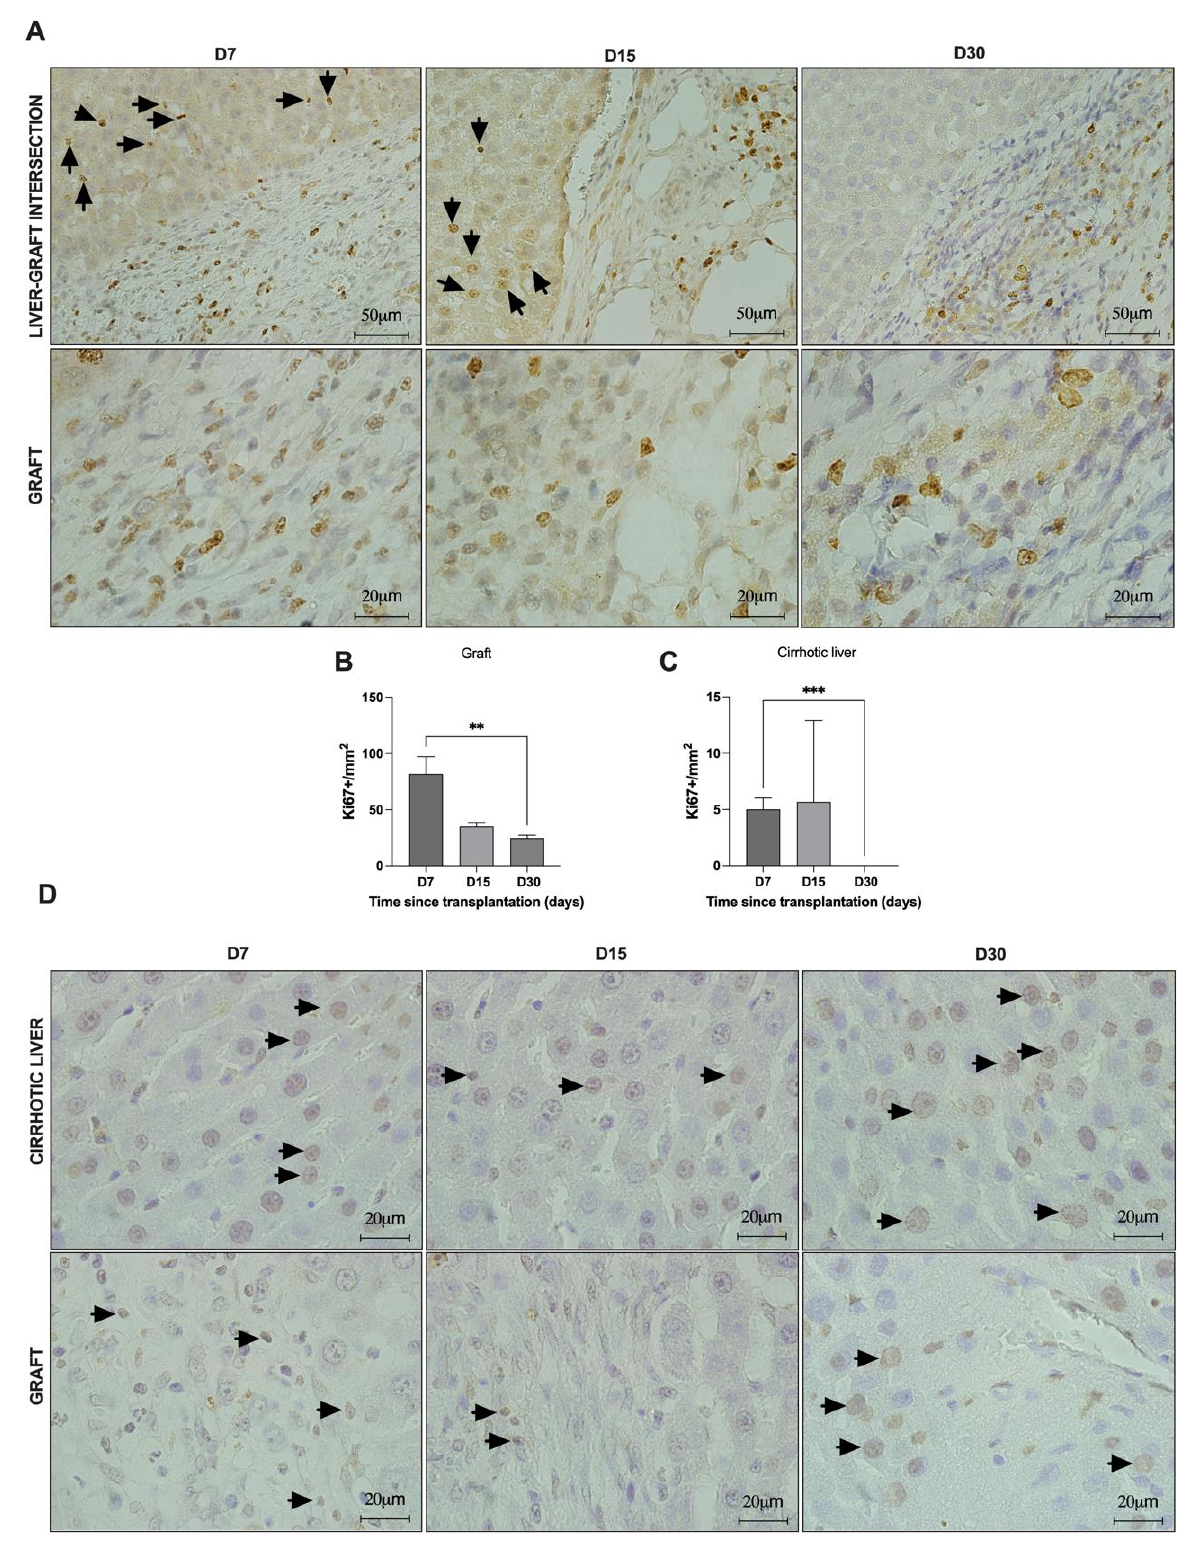
Figure 9. ALS transplantation promotes tissue remodeling in both cirrhotic liver and grafts. Im- munostaining ( A ) and quantification of Ki67-positive cells in the graft ( B ) and in the intersection area (liver-graft intersection) ( C ) at 7, 15, and 30 days post-transplantation. TUNEL-positive cells in cirrhotic liver ( D , top images ) and graft ( D , bottom images ) at 7, 15, and 30 days post-transplantation. Black arrows indicate Ki67- and TUNEL- positive cells. Scale bars: 20 µ m, ** p < 0.05, *** p = 0.0001).